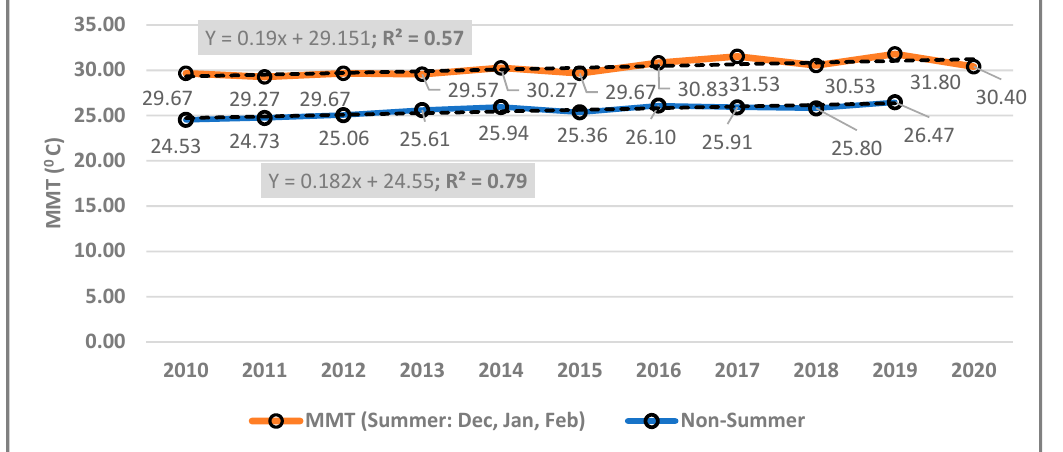
Figure 6. Variations in the trend of mean maximum temperature between summer and non-summer seasons from 2010 to 2020.